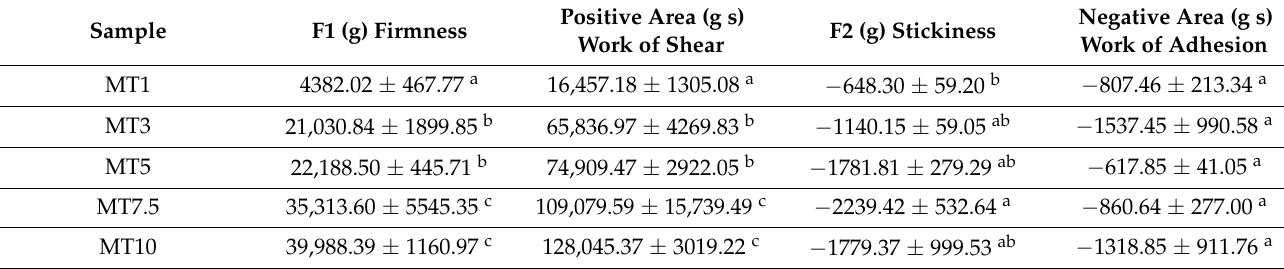
Table 2. Parameters obtained from the spreadability test of cookie dough. For each column, different letter(s) indicates significantly different values by the Tukey HSD test. The values were represented as Avg ±